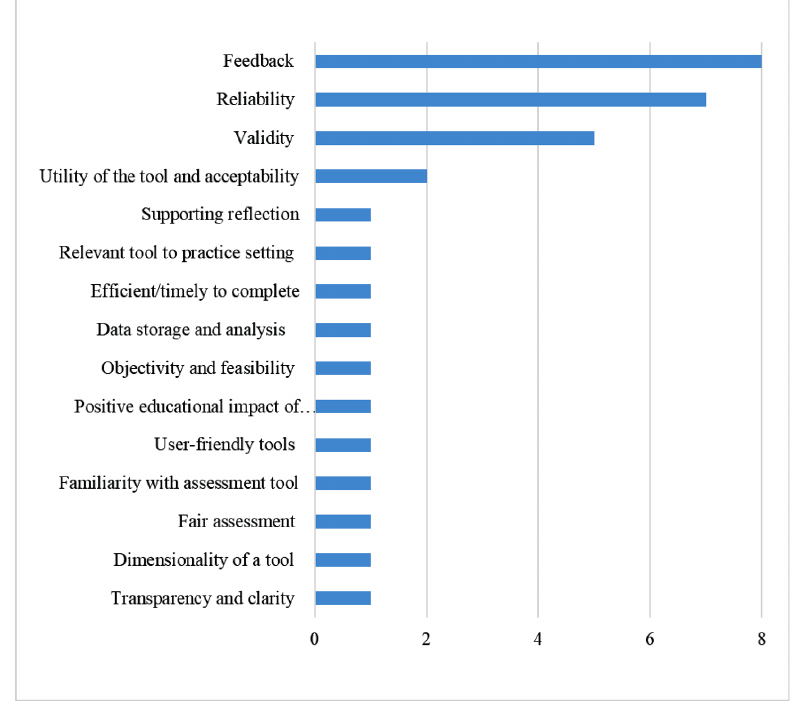
Figure 3. Quality criteria mentioned in the papers